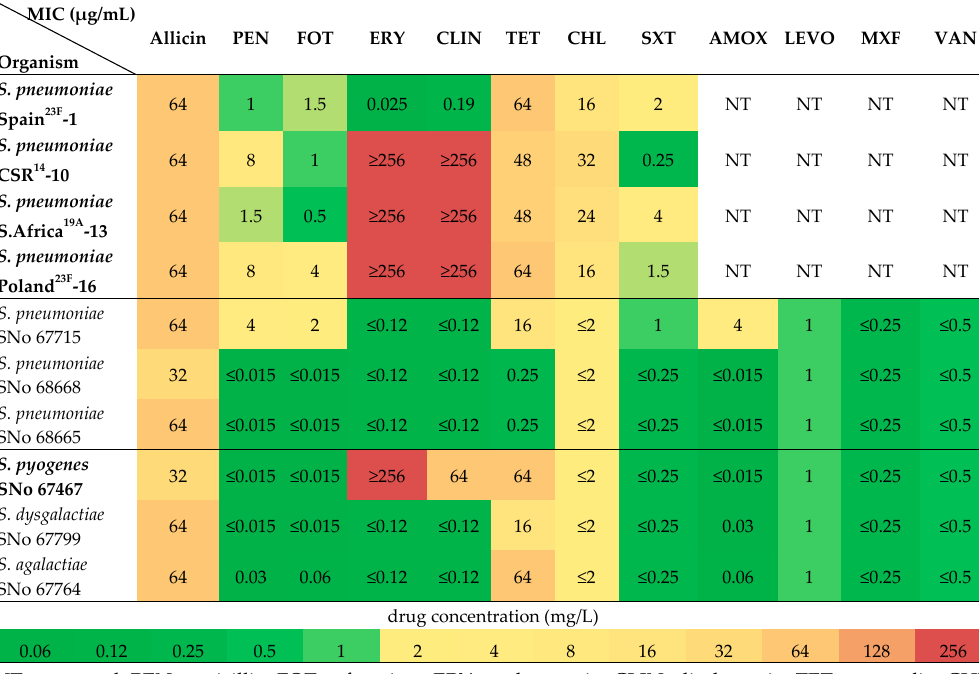
Table 2. Comparison of MICs for allicin and conventional antibiotics. MDR strains are shown in bold. The horizontal coloured bar, ranging from dark green through yellow to orange and red, indicates increasing concentration of test substances.